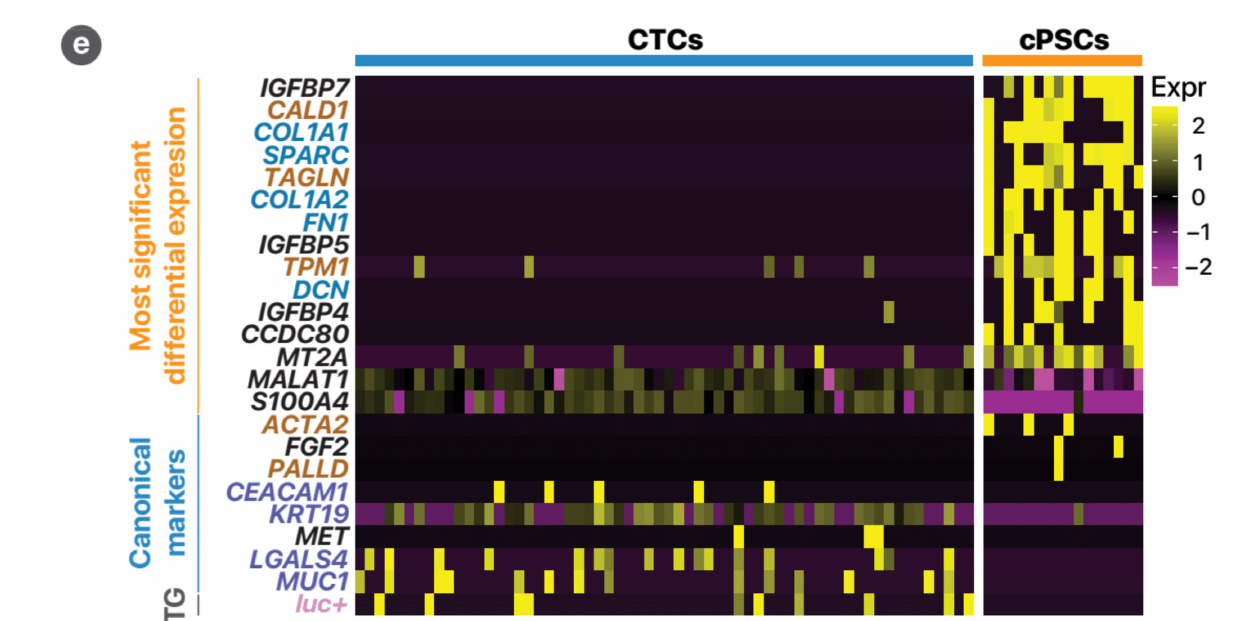
Figure 5. Identification of circulating pancreatic stellate cells using single-cell RNA-sequencing. ( a ) General circulating PSC identification strategy. The only human cell types implanted into the mice were AsPC-1 cancer cells and PSCs. Thus, by identification of human cells, one can narrow down the identity of cells to these two cell types. Circulating rare cells may then be identified by combining the cell type identity with the sample of origin (for instance, human cells in MsBlood must be circulating tumour cells (CTCs) or circulating PSCs). ( b ) Integration of human cells across the four samples for Approaches 1 and 2. This demonstrates that human cells from all four samples clustered into two distinct groups, representing PC cells and PSCs. Inset: The same plot, colour coded for presumptive cell type based on the UMAP co-ordinates of the cells (Approach 1). ( c ) Approach 3 avoids the assumptions of data integration. Instead, using cultured AsPC-1 and PSCs as reference, the top 500 genes predictive of the identity of each cell type was identified (i.e., 1000 genes in total). This was applied to the human cells within the blood sample to classify the cells using unsupervised clustering. Left panel: t-SNE plot showing the two clusters of cells representing CTCs and circulating PSCs. This approach yielded 20 circulating PSCs. Right panel: The same plot, coloured by the classification results from Approach 1, indicating good agreement between the two approaches. ( d ) This is a Venn diagram summarises the degree of agreement between the three approaches described. The overall agreement between each approach was high. There were 14 cells which were identified by all three approaches, which represent the cells identified with high confidence as circulating PSCs in this experiment. ( e ) This heatmap demonstrates the differences in gene expression between CTCs and circulating PSCs identified using Approach 1. The upper half of the heatmap (marked on the left with orange) represents the most significant differentially expressed genes (false discovery rate < 10%). This is followed by other known canonical markers (blue) and finally the luciferase transgene. The gene names are also colour-coded. Brown represents genes for myofibroblast or cytoskeletal proteins associated with PSCs. Blue represents extracellular matrix proteins associated with PSCs. Purple represents epithelial proteins associated with PC cells. Pink represents the luciferase transgene of AsPC-1 cells used in this